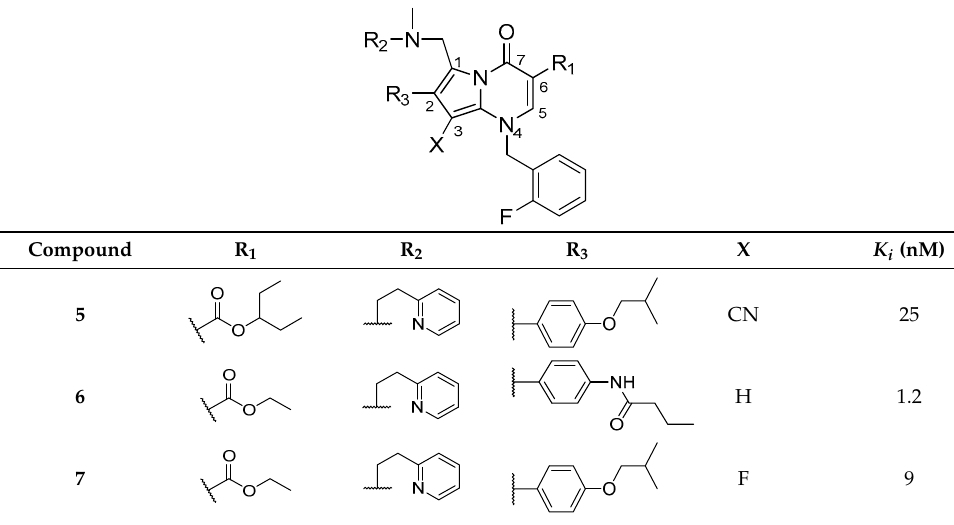
Table 3. Pyrrolo[1,2- a ]pyrimidin-7-one derivatives and their binding affinity at human GnRH-R.